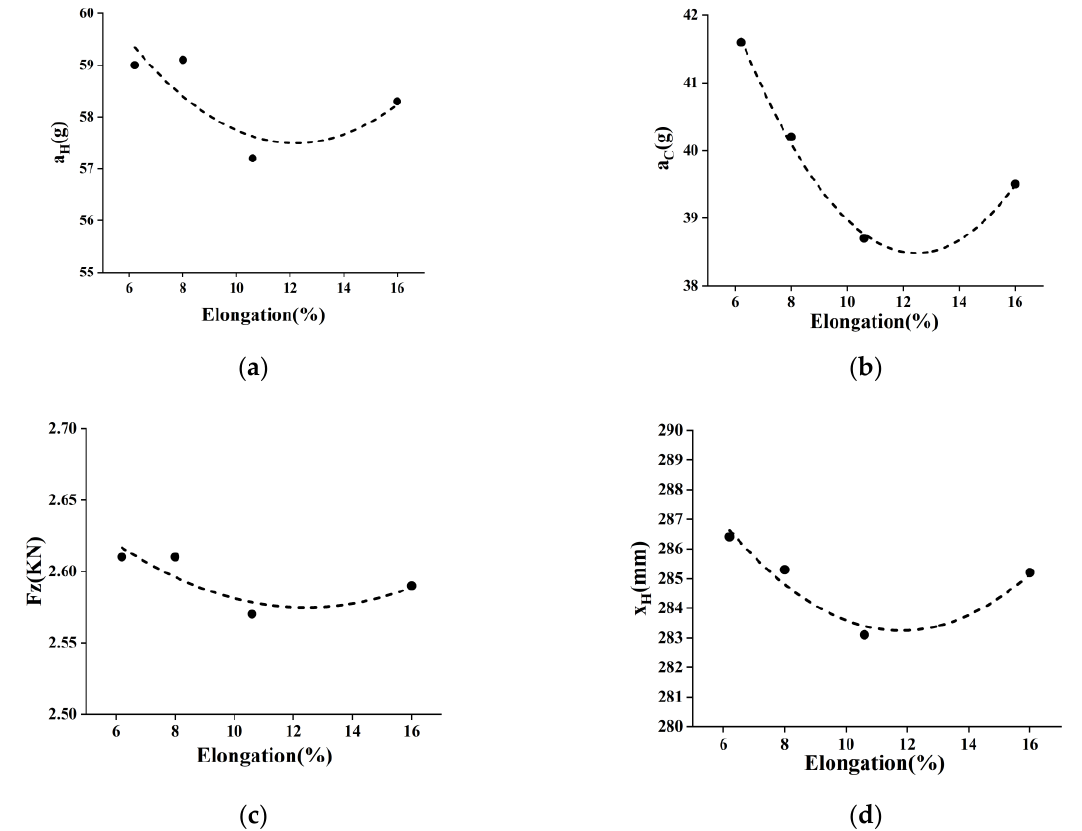
Figure 10. A value of 3 ms head resultant acceleration 𝑎 𝐻 variation ( a ), 3 ms chest resultant acceler- ation 𝑎 𝐶 variation ( b ), upper neck tension 𝐹 𝑍 variation ( c ), the head horizontal displacement 𝑥 𝐻 variation ( d ), caused by the elongation adjustment.